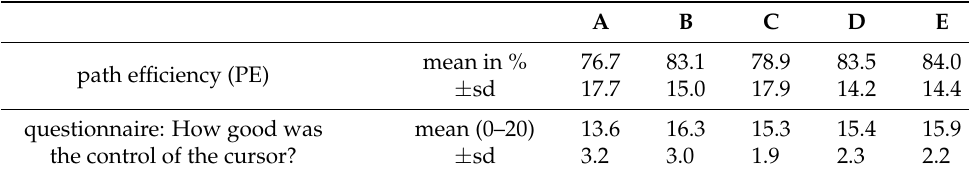
Table 2. Path efficiency and results of the questionnaire. The table show the path efficiency during the gross motion section of the AT over all subjects. The questionnaire asked the subjects how well they could control the cursor during each experiment. They could rate from 0 to 20, where 0 represented bad control of the cursor and 20 represented a perfect